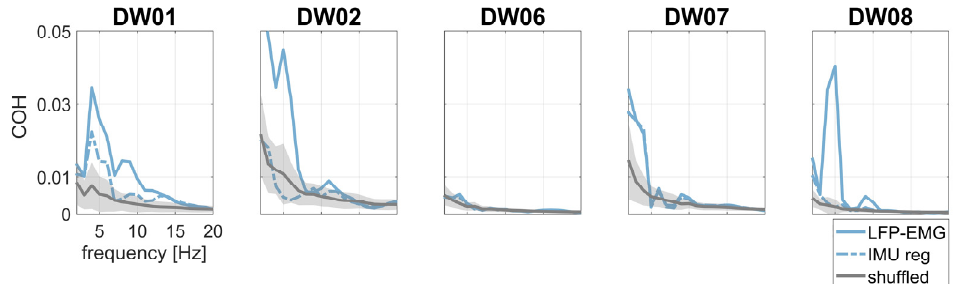
Figure 5. Pallido-muscular COH without (continuous, light blue line) and with (dotted, light blue line) IMU regression. Surrogate data are shown in gray as the mean (continuous line) ±2 standard deviations (shaded area).